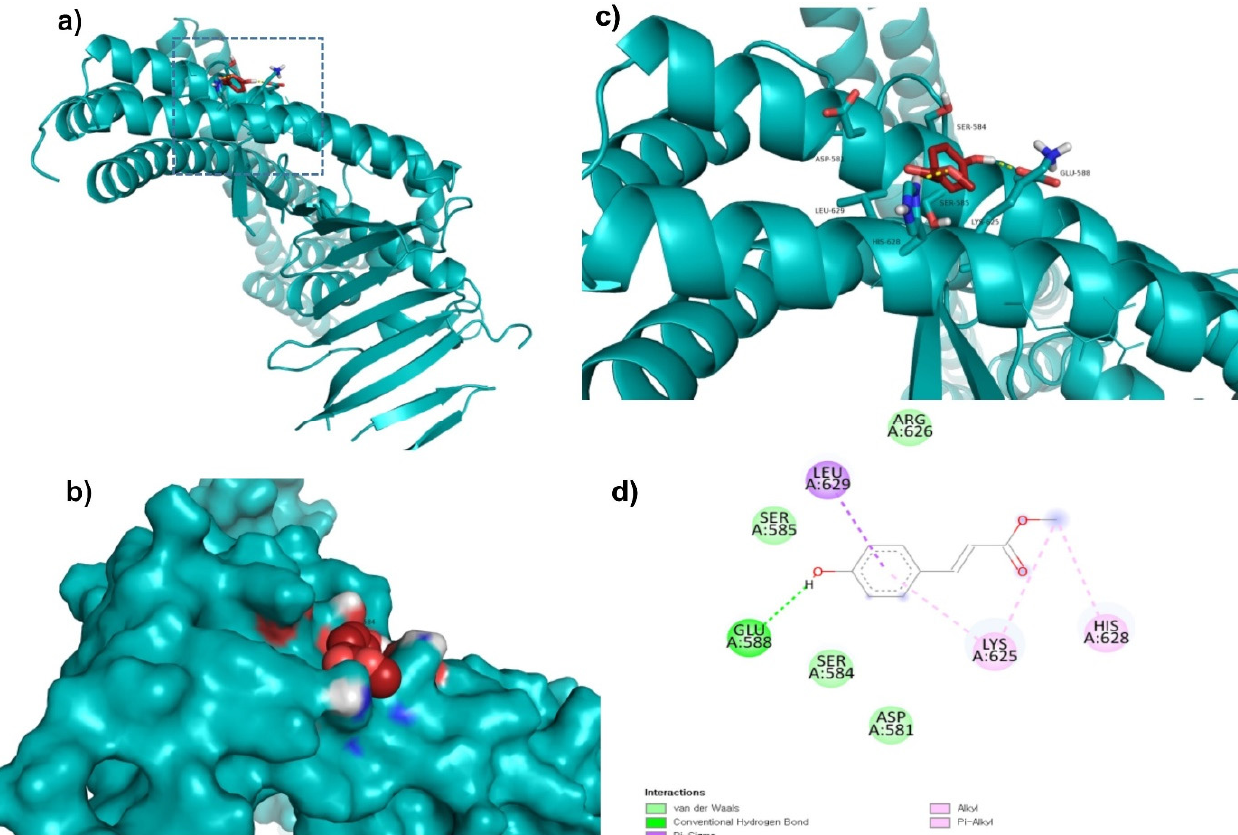
Figure 1. Visualization and surface view of ZINC153731 in the active site of CagA protein ( a , b ). Three-dimensional ( c ) and 2D ( d ) view of CagA residue interacting with ZINC153731.